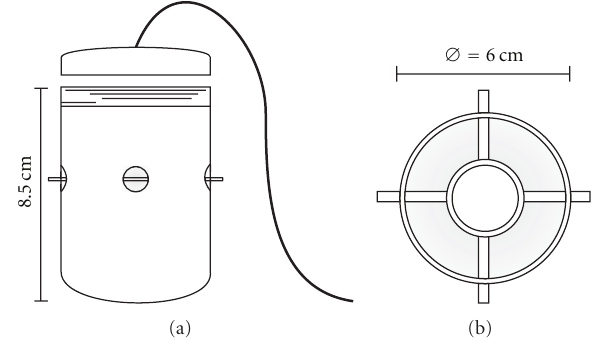
Figure 1: Schematic external (a) and internal (b) view of the sub- terranean pitfall